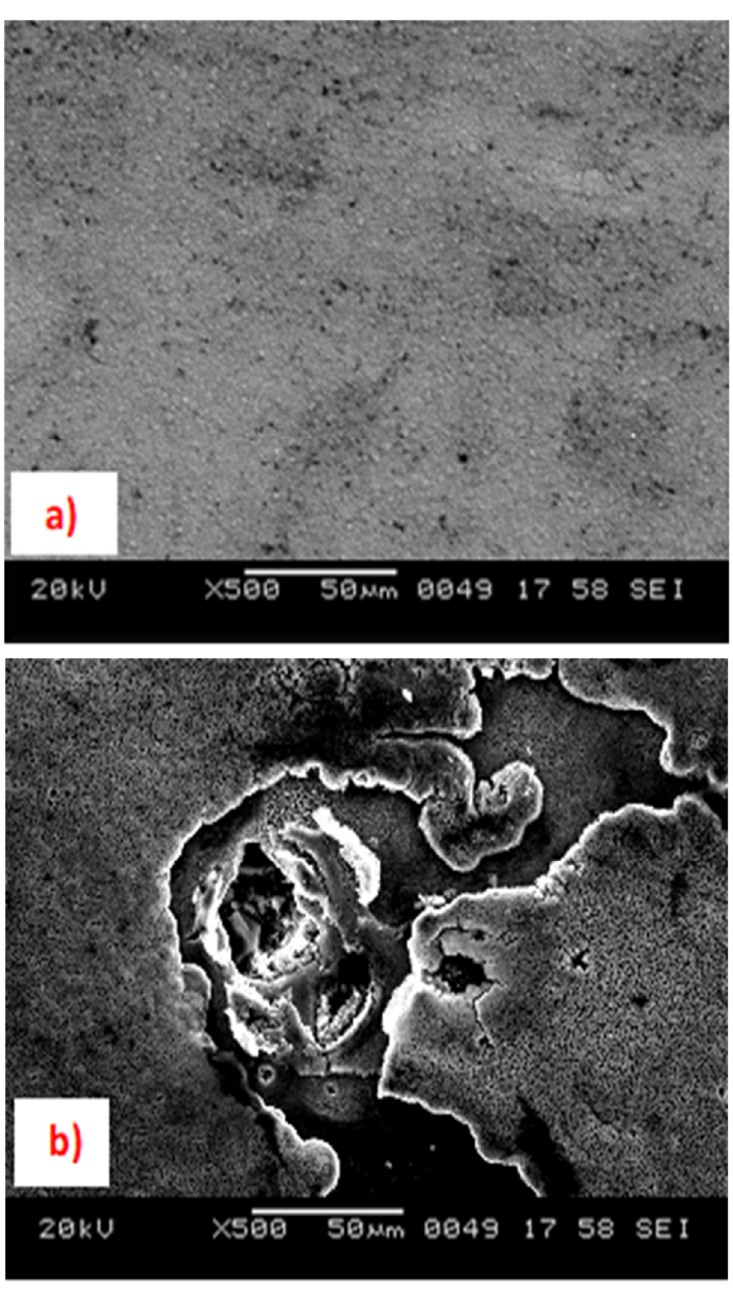
Figure 6. Surface topography of single-layer Zn-Fe alloy electroplating ( a ); the surface after corrosion test ( b ).